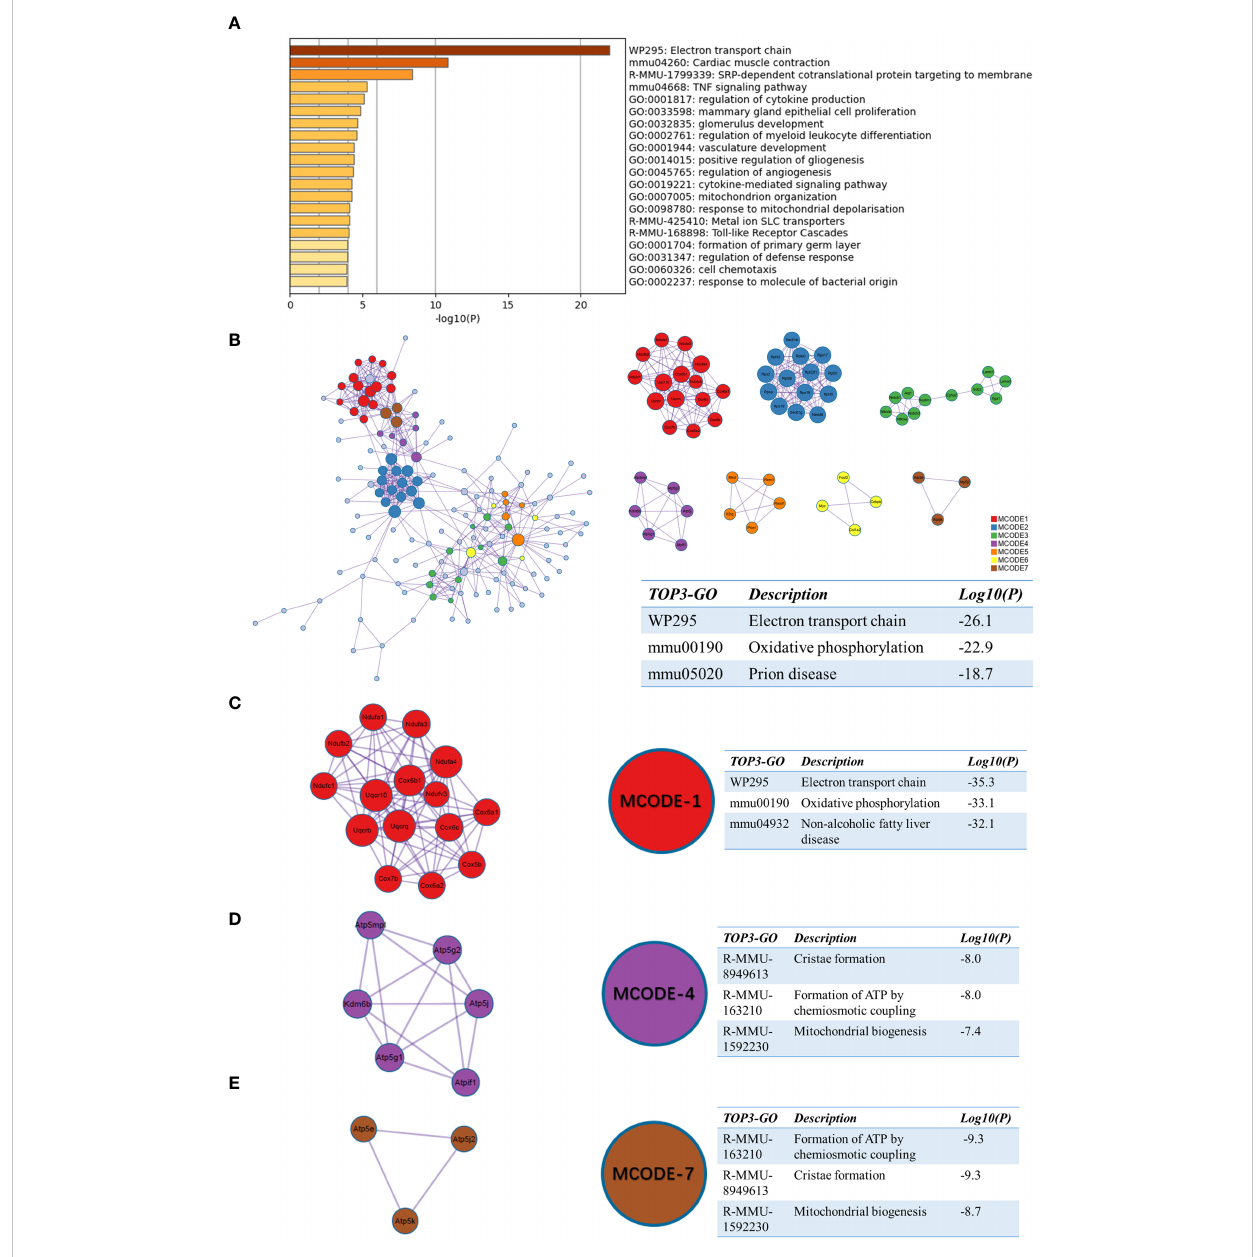
FIGURE 4 Functional enrichment of the sc_S5 on day 1 after tMCAO. (A) The top 20 enriched terms of the sc_S5 on day 1 by Metascape, colored by p-values. (B) Protein-protein interaction network and all MCODE components identi fi ed of the sc_S5 on day 1. (C – E) Representative MCODEs with correlation to enrichment analysis of the